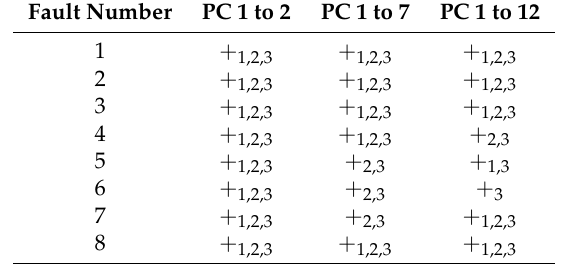
Table 3. Results of the normality tests when considering the first two principal components, the first seven principal components and the first twelve principal components. “ − ” means that all the tests rejected multivariate normality while “ + ” means that at least one test indicated multivariate normality. In this last case, the subindex shows the tests that indicated multinormality: 1 (Mardia’s test), 2 (Henze–Zirkler’s test), or 3 (Royston’s test). Fault Number PC 1 to 2 PC 1 to 7 PC 1 to